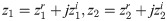
Time response for controlled Duffing CVCSs Eq (38) with the adaptive complex scalar controller Eq (39) and complex update law Eqs (40) and (41), and at the same parameter values and initial conditions as in Fig 1.(A): Time response of the complex state variables z1=z1r+jz1i,z2=z2r+jz2i. (B): Time response of the complex scalar controller u(t) = ur(t) + jui(t). (C): Time response of uncertain complex parameter estimation θ^=θ^r+jθ^i.